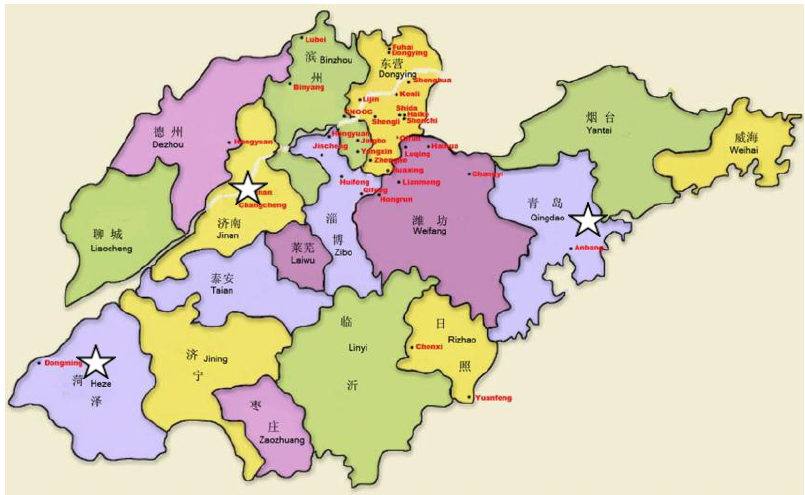
Figure 1. Location of the study population. Shandong Province, located in the east of China, has a population of 92.8 million people and a land area of 153,300 km 2 . We included 418 research participants from Qingdao, 345 from Jinan, and 539 from Heze. ☆ : Sample collection areas.